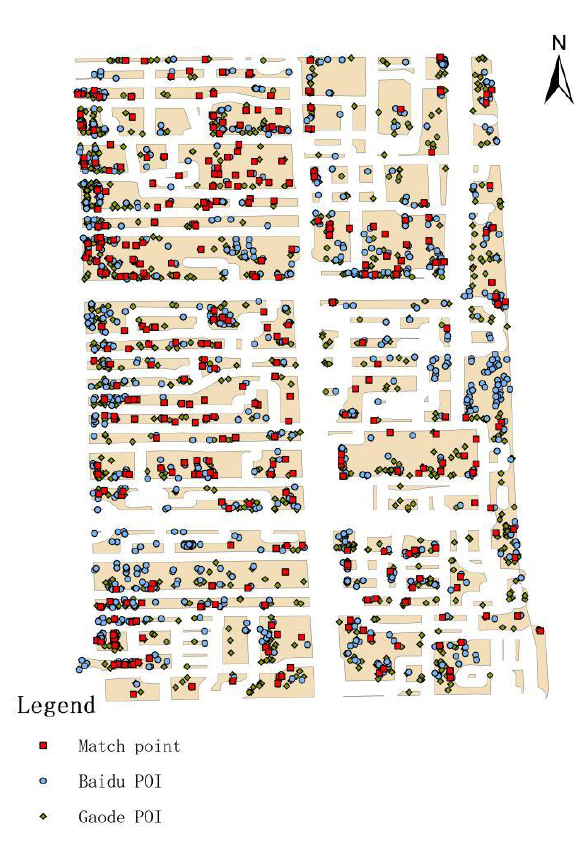
Figure 4 . Recognition results of entities with the same name.